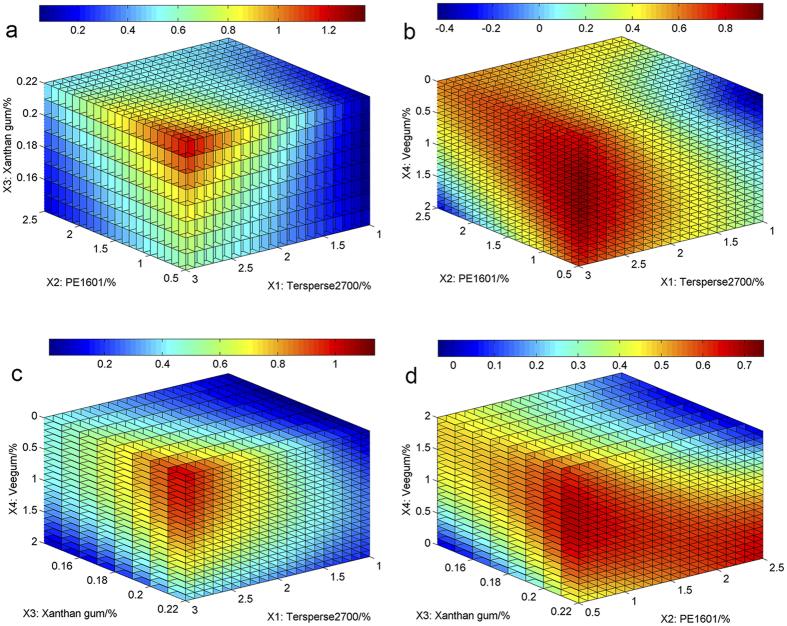
Four-dimensional response surfaces that reveal the influences of X1X2X3, X1X2X4, X1X3X4, and X2X3X4. The colour bar represents the total desirability.